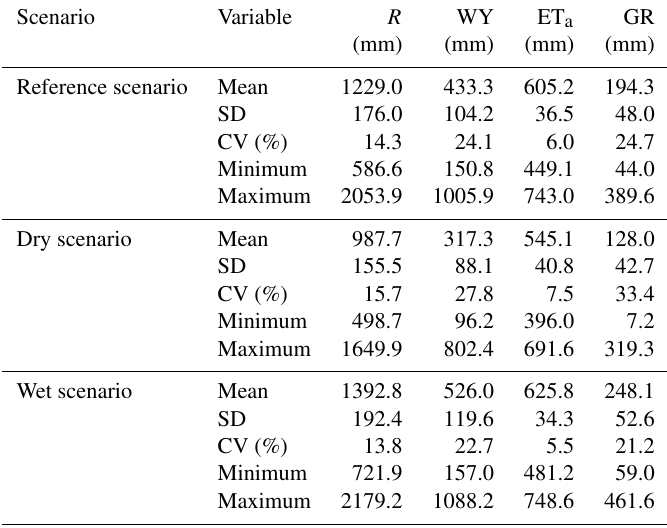
Table 4. Descriptive statistics of annual water balance components obtained in the three scenarios in the static approach. Units are in millimeters, except for CV (%). SD: standard deviation; CV: coefficient of variation.